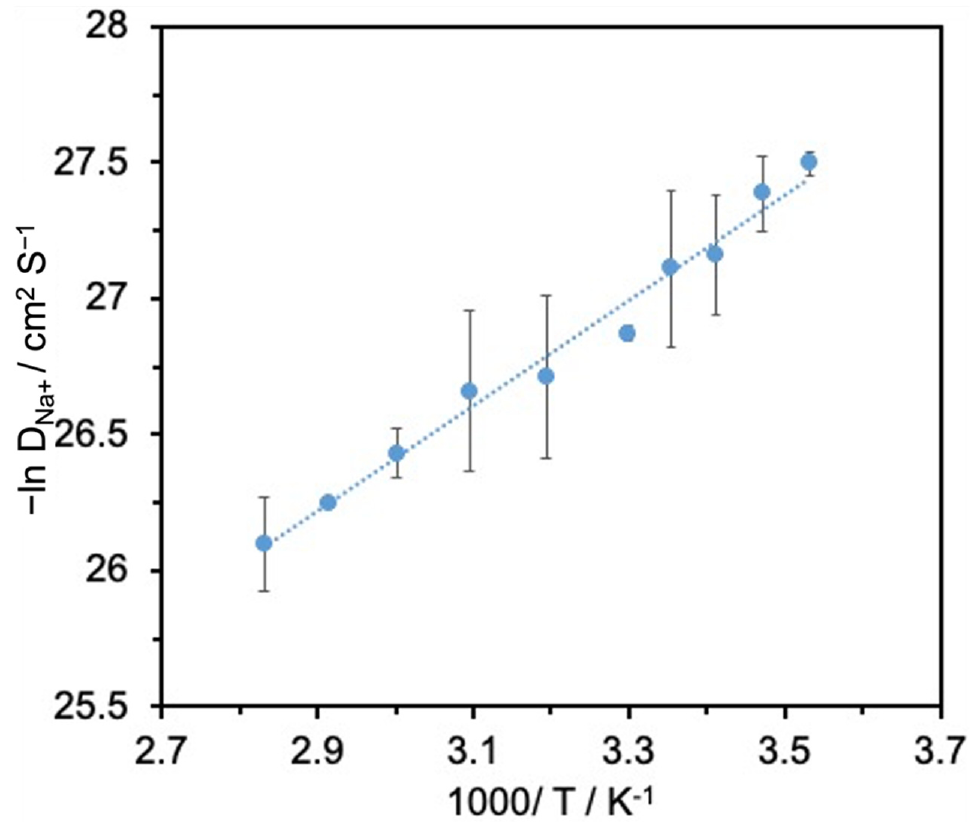
Figure 8. Dependence of natural logarithm of the average Na + diffusion coefficient on reciprocal temperature.